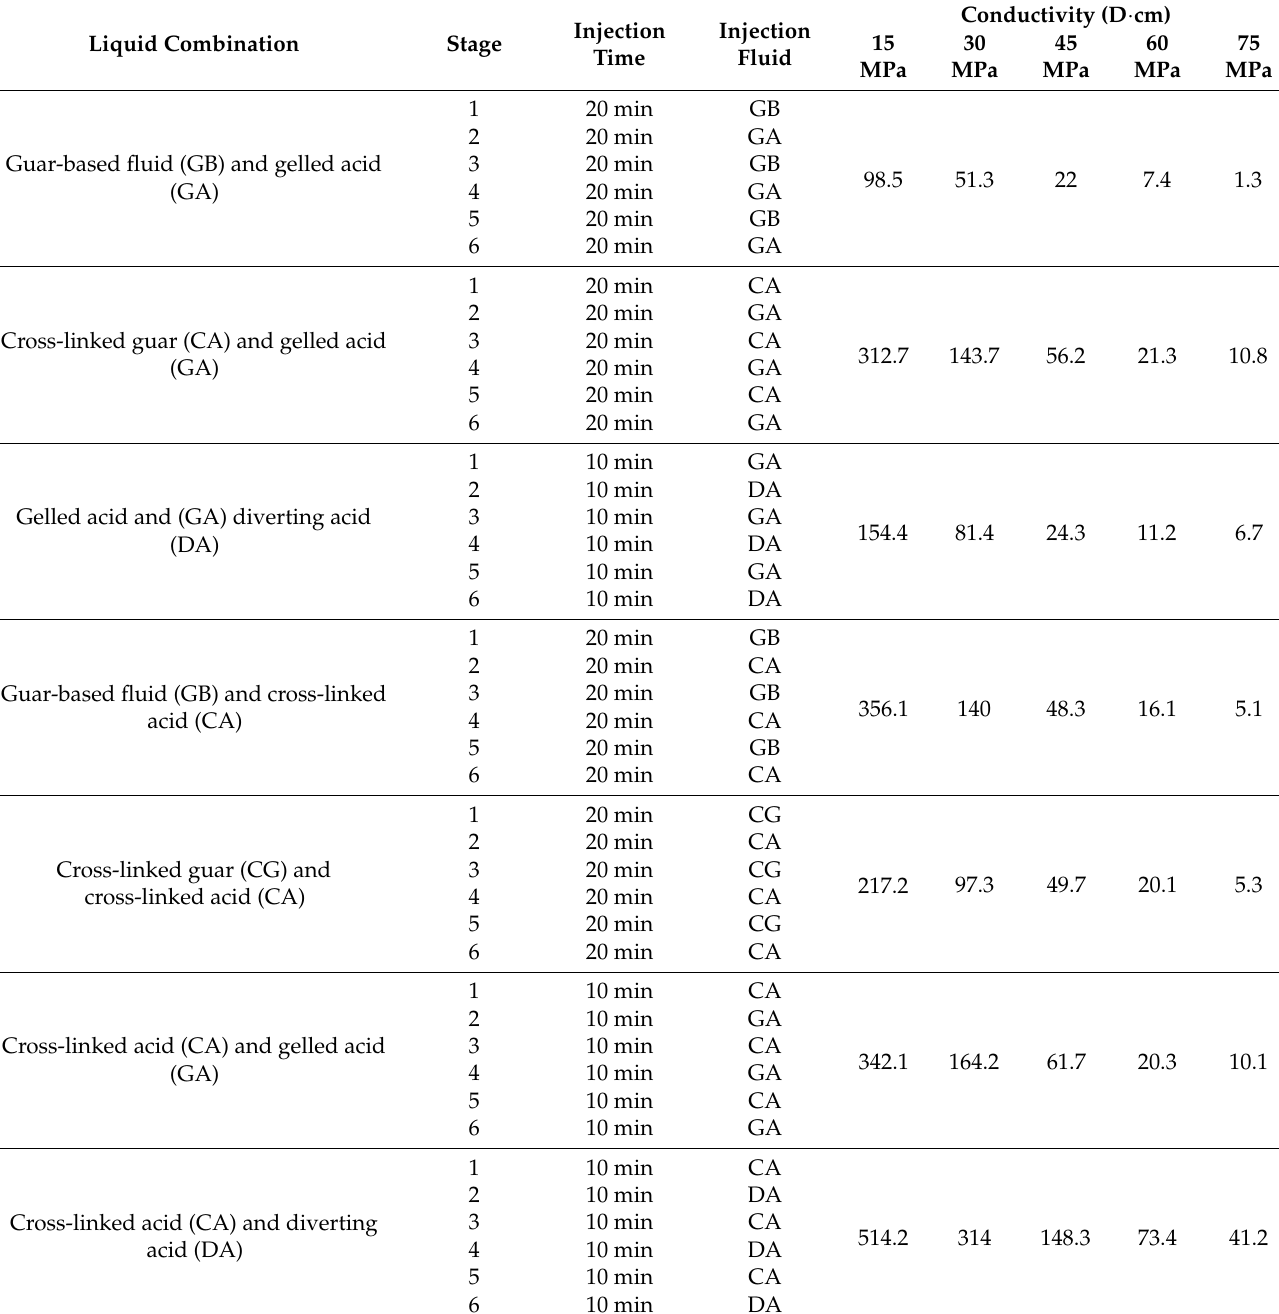
Table 1. Multistage acid fracturing test arrangement and conductivity test